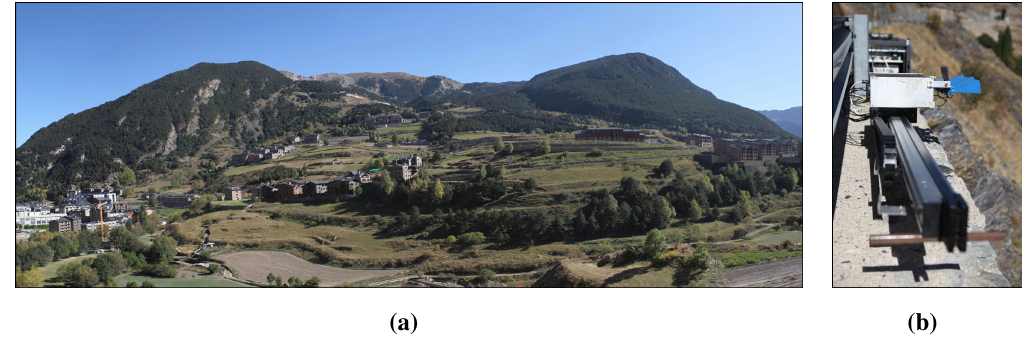
Figure 3. ( a ) Panoramic view of El Forn de Canillo from ( b ) the RiskSAR-X point of view. Regarding the RiskSAR-X characteristics, it is based on the usage of a digital direct synthesizer (DDS) chipset that generates a high rate linear frequency modulated continuous wave (LFM-CW)